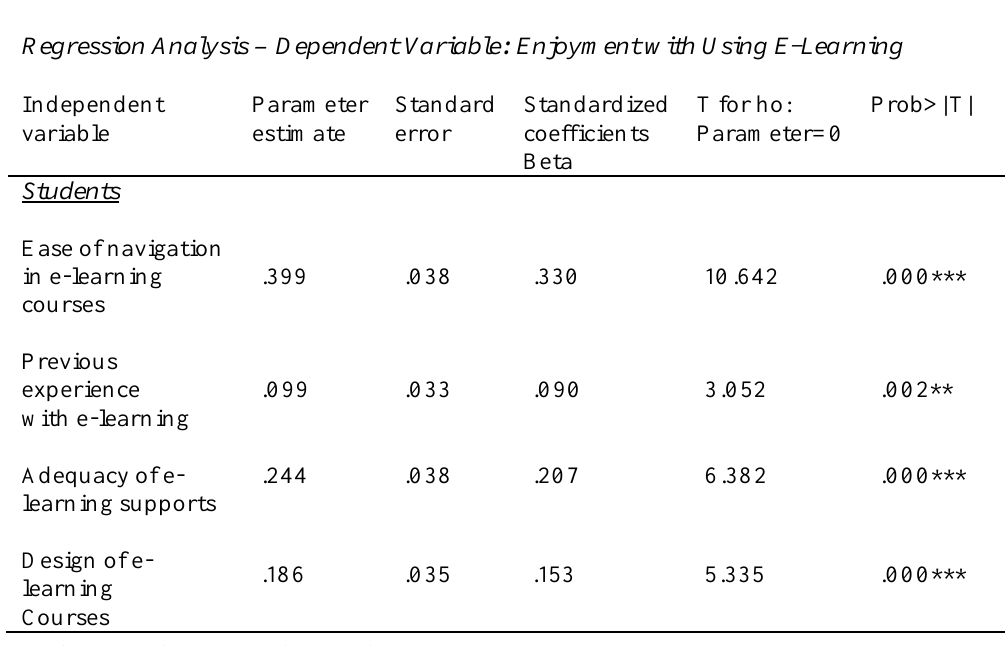
Parameter Standard Standardized estimate error coefficients